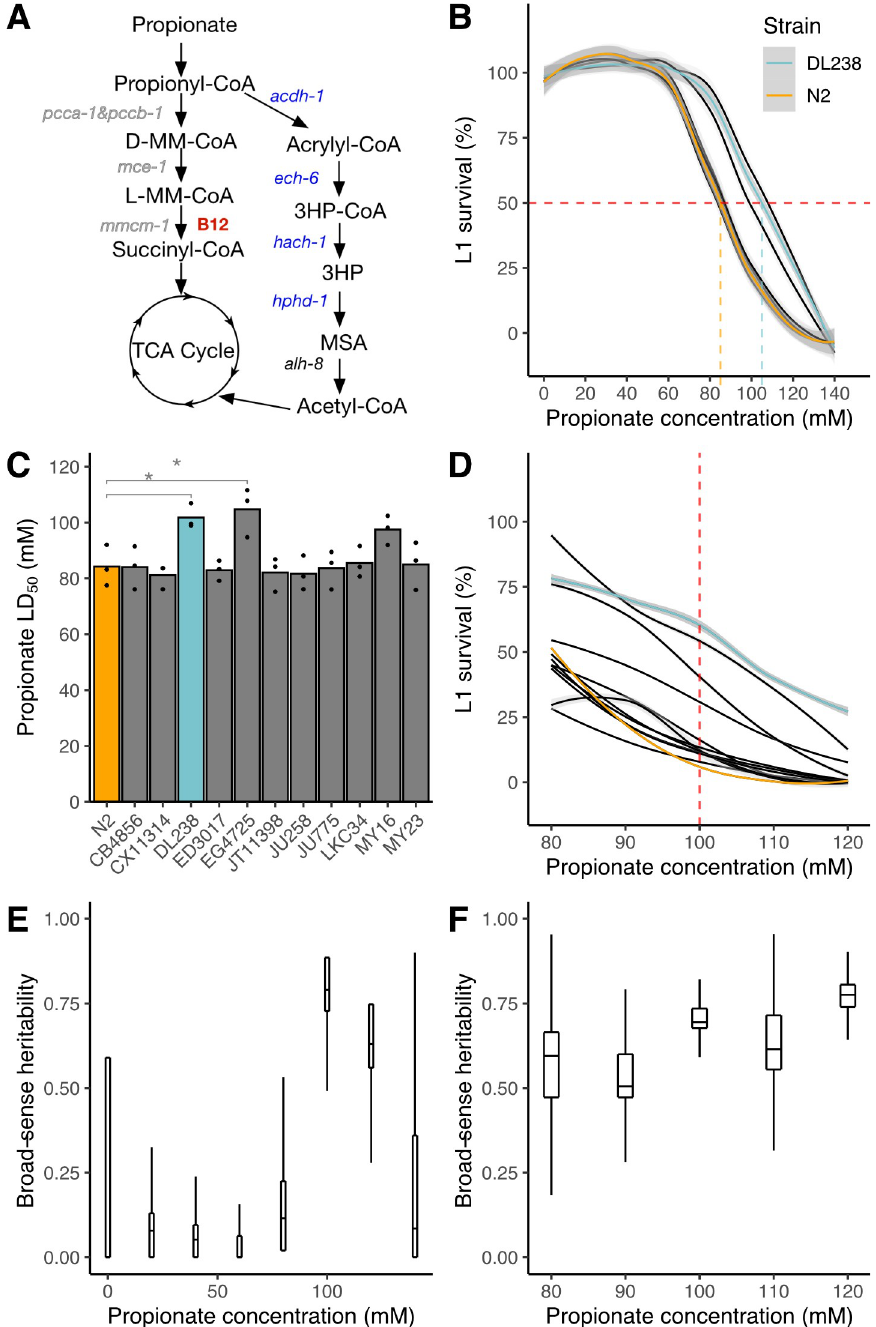
Fig 1. Natural variation in propionate sensitivity in 12 genetically diverse C . elegans strains. (A) Propionate breakdown pathways in C . elegans . MM–methylmalonyl; TCA–tricarboxylic acid; MSA–malonic semialdehyde; HP– hydroxypropionate. (B) Propionate dose-response curves (DRCs) for 12 genetically distinct wild C . elegans strains. The Loess-smoothed fits of three biological replicates, each comprising three technical replicates, is shown by solid colored lines, and the standard error of the fit is shown in gray. For reference, the DRCs are colored for the N2 (orange, propionate-sensitive) and DL238 (blue, propionate-resistant) strains. We note that the DRCs of nine strains overlap with the N2 DRC. The horizontal dashed red line indicates 50% L1 survival and the vertical colored lines represent the LD 50 concentration for N2 and DL238. (C) LD 50 values of L1 survival after propionate exposure for the 12 wild C . elegans strains. Three biological replicates each with three technical replicates were performed. ( � indicates Student’s t- Test p < 0.05. After adjusting for multiple testing, the p-value for the DL238—N2 comparison is 0.087 and the